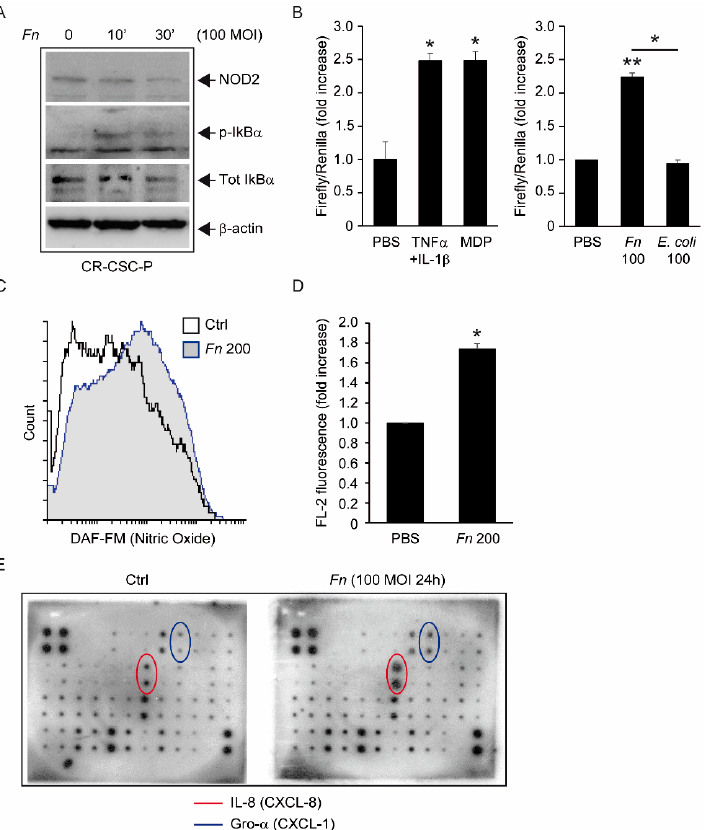
Figure 2. Proinflammatory signaling of Fn in CSC. ( A ) Immunoblot analysis of CSC-P homogenates following short (10 ′ and 30 ′ ) exposure to 100 MOI Fn . Bands corresponding to the bacterial sensor NOD2, the phosphorylated (Ser 32) form of the NF-kB inhibitor IkB, total IkB, and β -actin (loading control) are highlighted by arrows. Picture representative of at least three independent